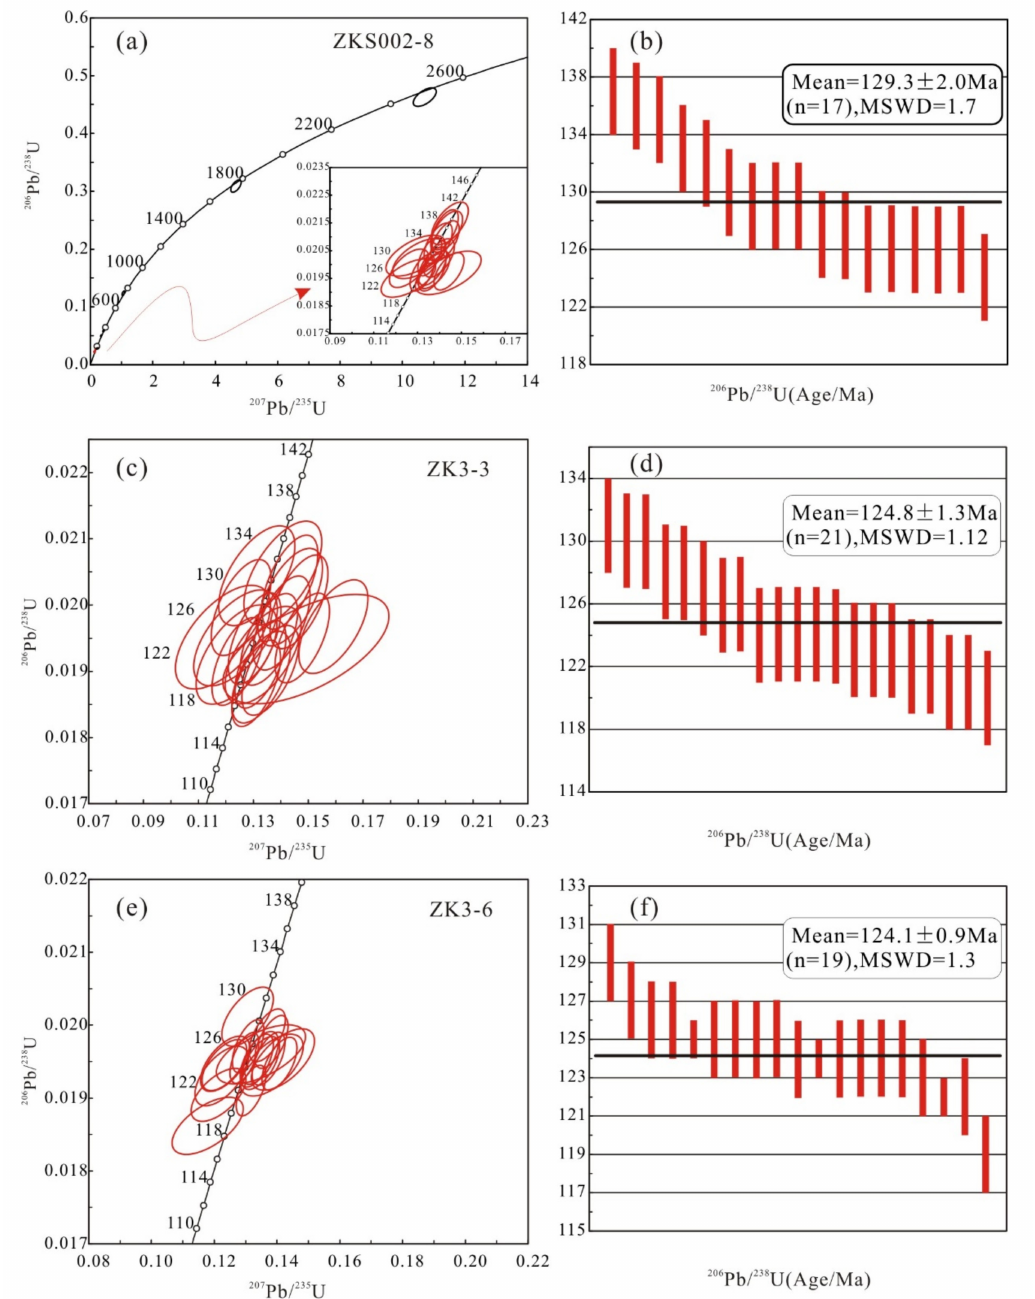
Figure 6. ( a , c , e ) U-Pb concordia diagrams of the FBAS, MD, and GD, respectively; ( b , d , f ) weighted mean 206 Pb/ 238 U ages diagrams of the FBAS, MD, and GD, respectively. MSWD= mean square weighted